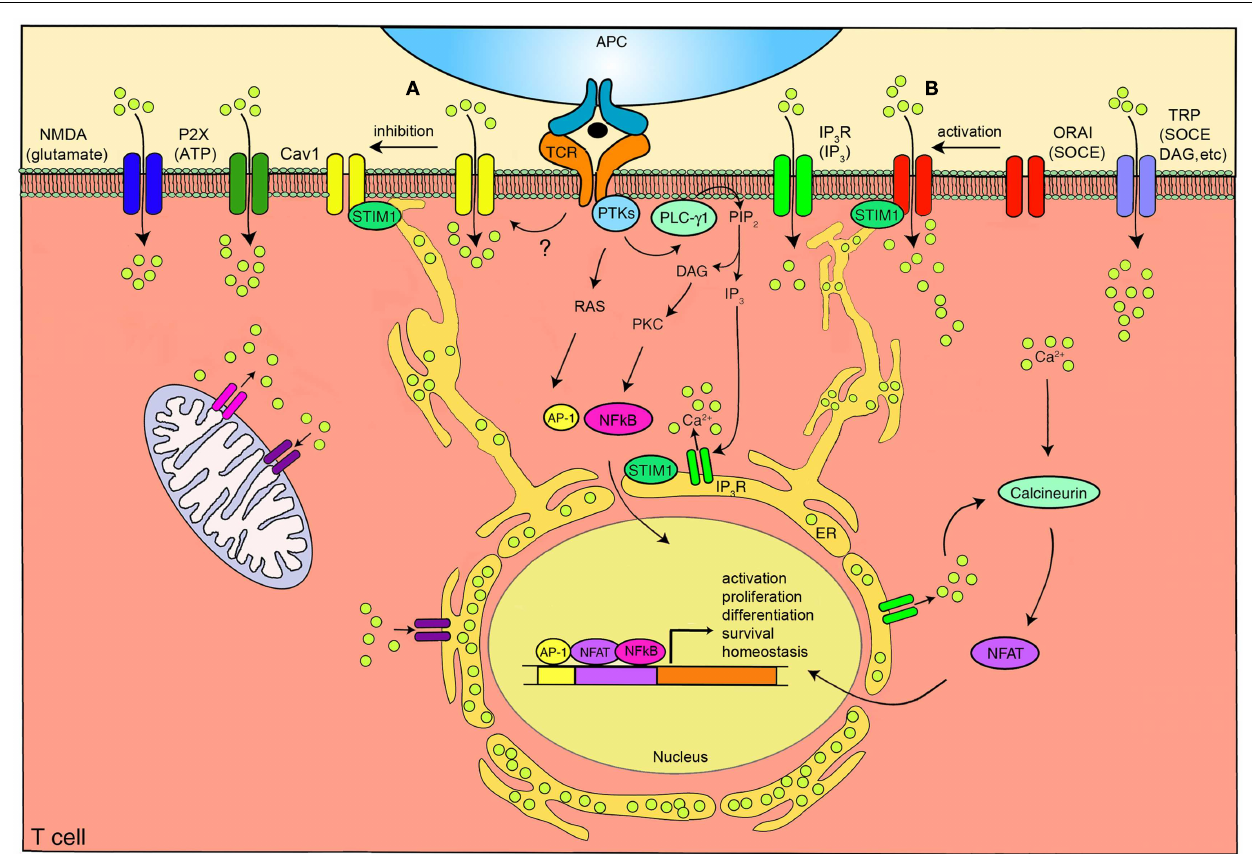
induces nuclear factor of activatedT cells (NFAT) nuclear translocation and transcription of target genes to directT cell homeostasis, activation, proliferation, differentiation, and survival.Within this complex network of Ca 2 + signaling, a model of the reciprocal regulation of Ca V 1 and ORAI1 inT cells has been proposed. (A) Low-levelTCR signaling through interactions with self-antigens (i.e., self-peptides/self-MHC molecules) may result in Ca V 1 (particularly Ca V 1.4) activation and Ca 2 + influx from outside the cell. This allows for filling of intracellular stores and initiation of a signaling cascade to activate a pro-survival program within the naïveT cell. Stromal interaction molecule 1 (STIM1) is not activated in this scenario and, consequently, ORAI1 remains closed. (B) StrongTCR signaling through engagement by a foreign peptide-MHC induces the downstream signaling events that result in ER Ca 2 + store depletion and STIM1 accumulation in puncta in regions of the ER near the plasma membrane allowing interactions with Ca 2 + channels. ORAI1 enhances STIM1 recruitment to the vicinity of Ca V 1 channels. Here, STIM1 can activate ORAI1 while